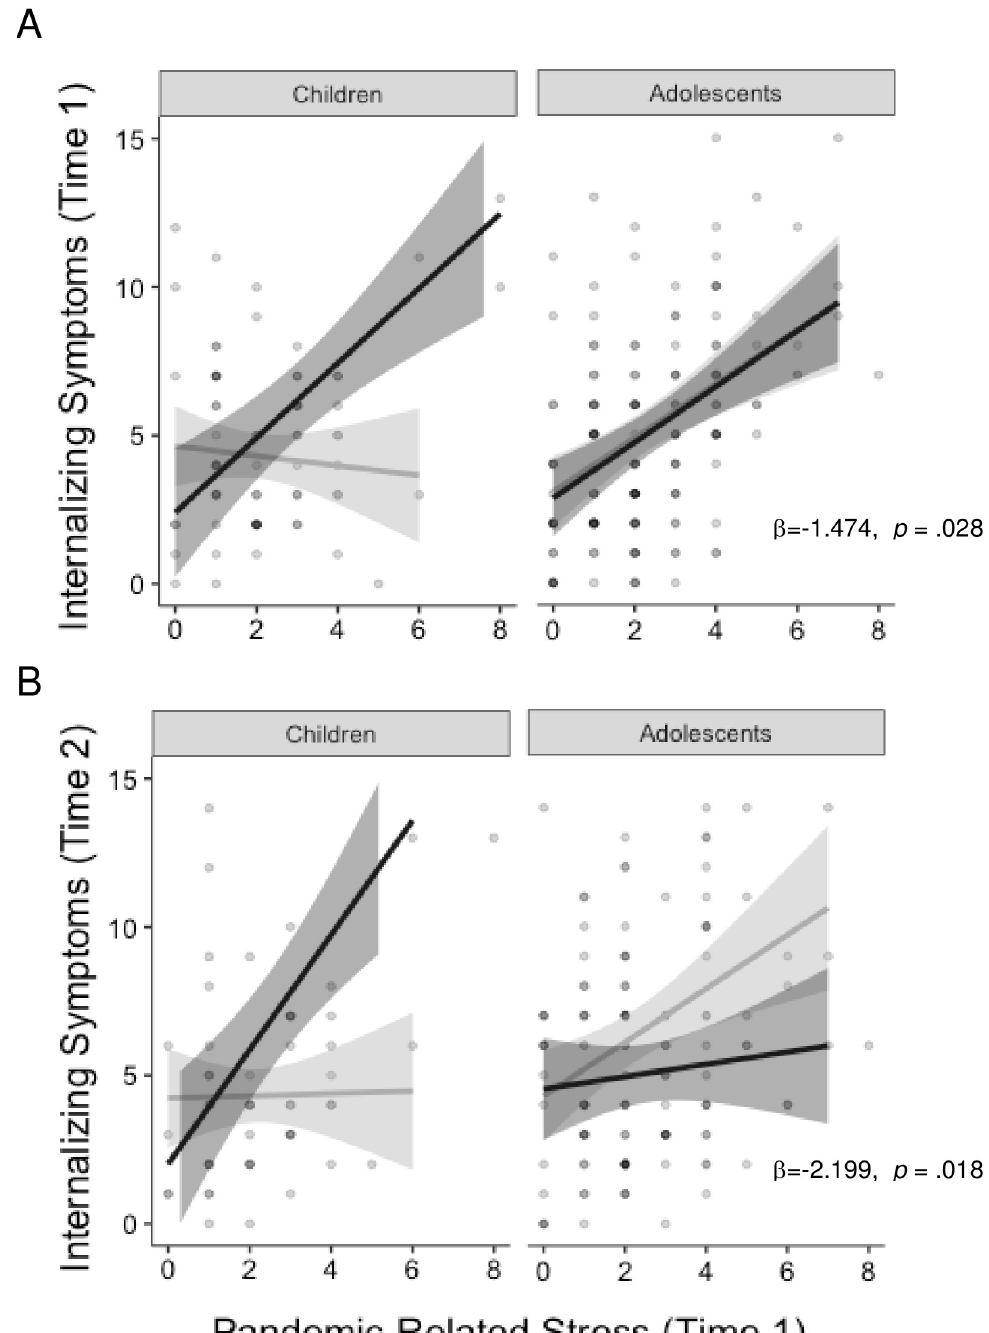
Fig 4. Age x stress x news interaction. Low news consumption buffers children, but not adolescents, against pandemic- related increases in internalizing psychopathology concurrently (A) and prospectively (B). All analyses control for age, sex, income-to-needs ratio, and pre-pandemic psychopathology